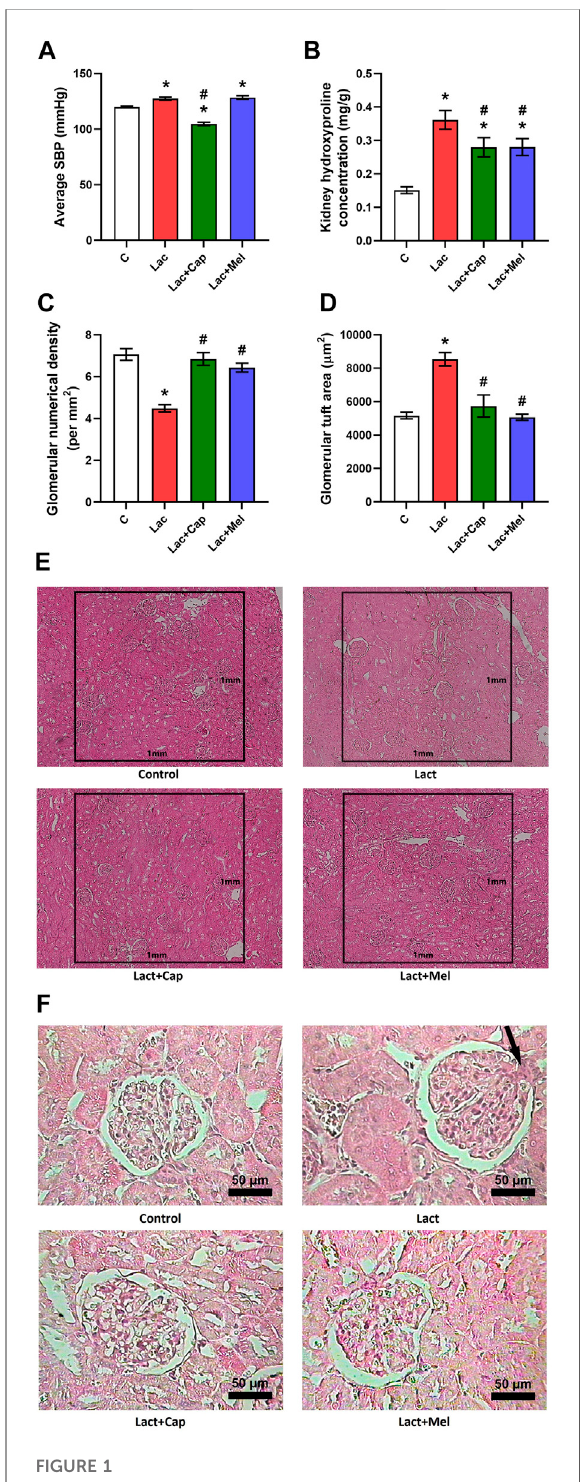
FIGURE 1 Effect of captopril (Lac + Cap) and melatonin (Lac + Mel) on